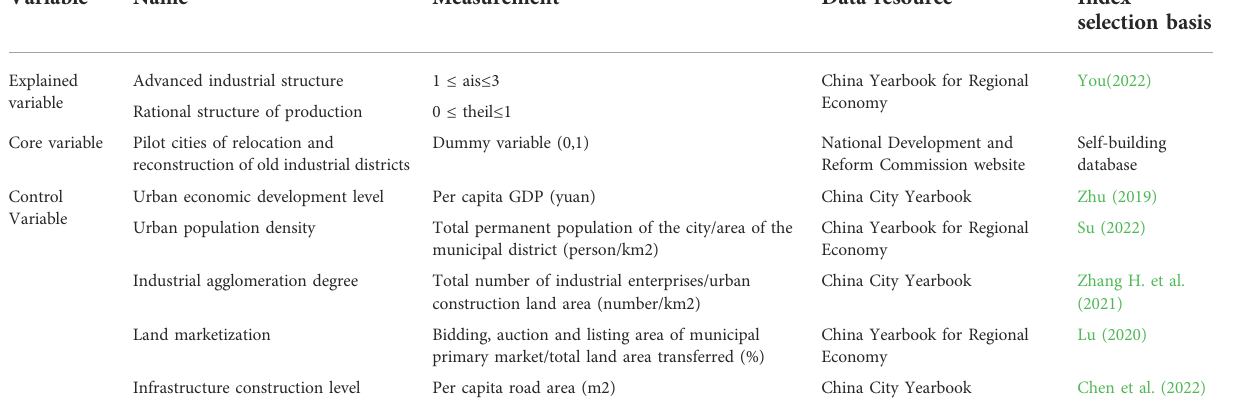
TABLE 2 Meaning, measurement and data source of main variables.